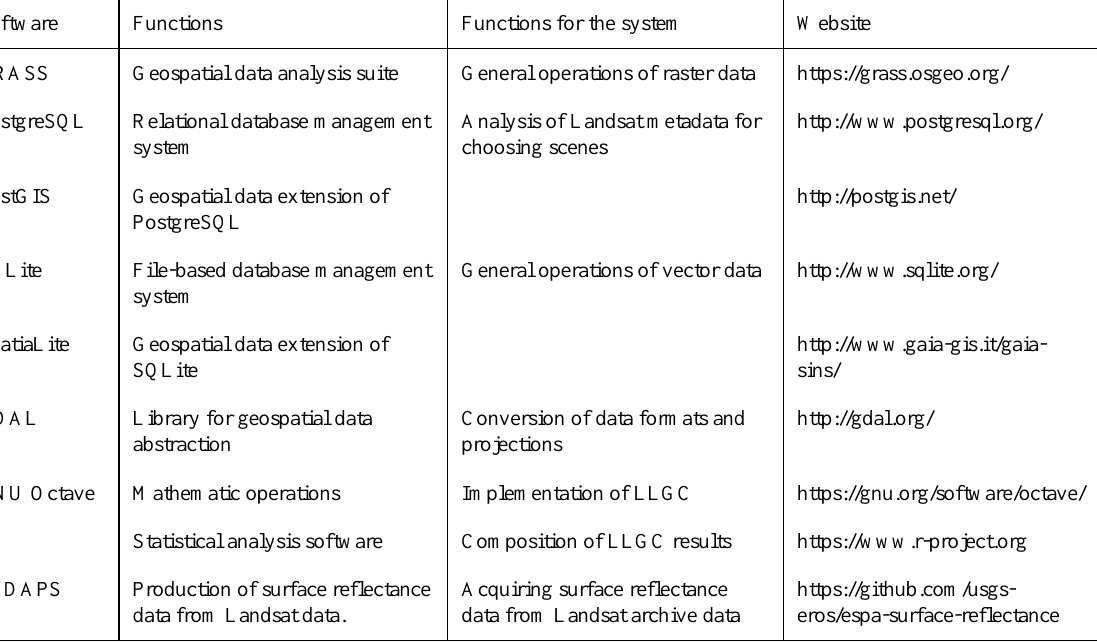
Table 1. List of software used for the human settlement mapping